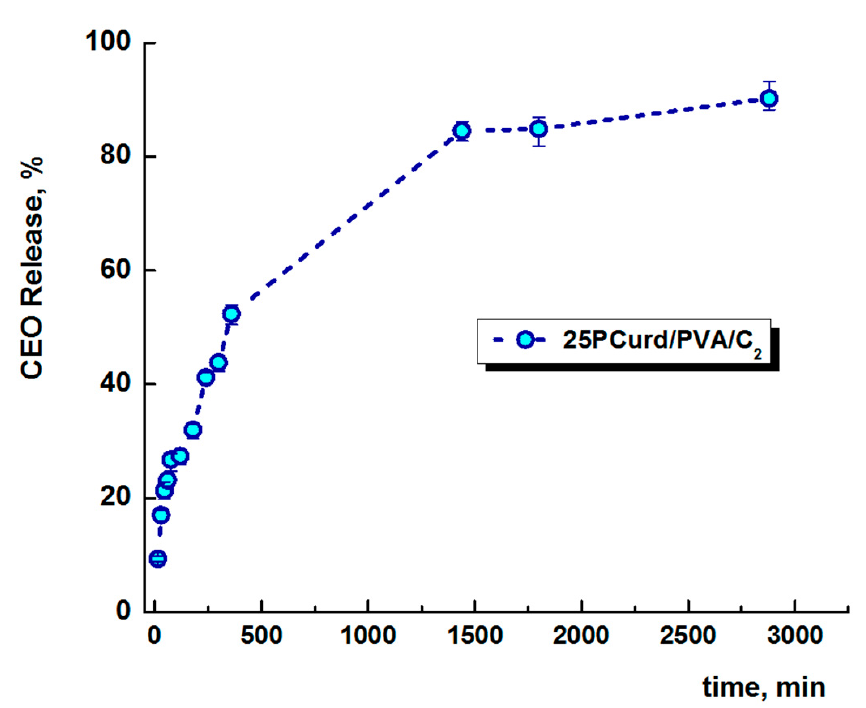
Figure 5. The release profile of clove essential oil from 25PCurd/PVA/C electrospun membrane at 32 °C and pH 5.5.